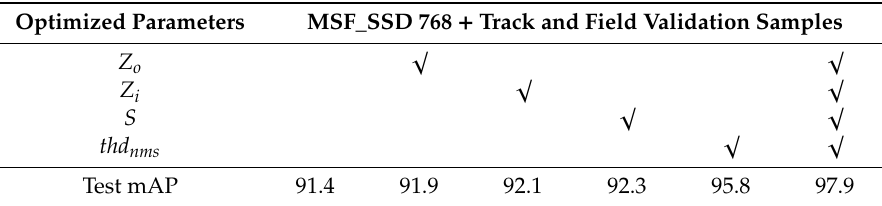
Table 5. E ff ects of various geometric parameters on MSF_SSD Table 5. Effects of various geometric parameters on MSF_SSD performance.